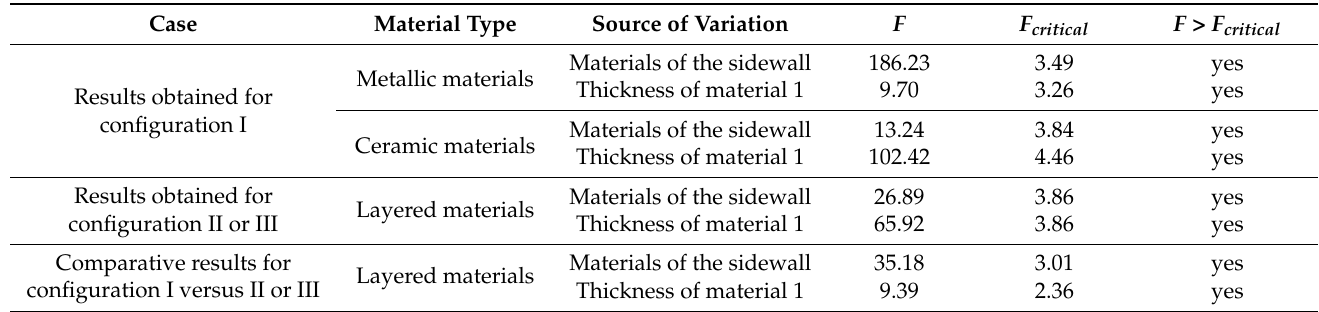
Table 5. Two-way ANOVA applied to results of the total heat supplied to the